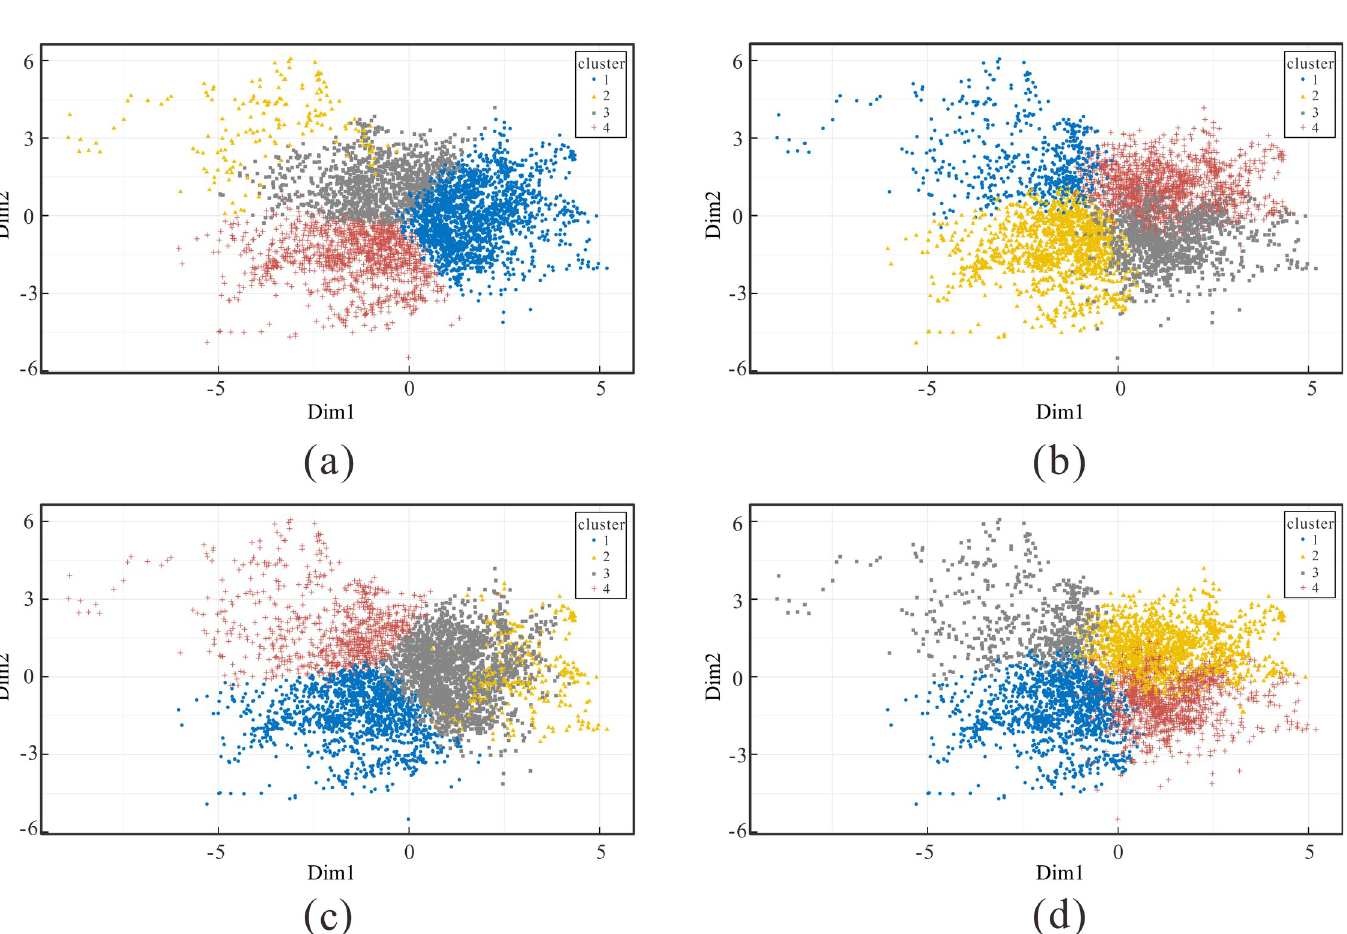
Fig 7. Comparison of the results of the improved algorithm and k-means algorithm: (a) improved algorithm; (b) k-means algorithm (first test); (c) k-means algorithm (second test); (d) k-means algorithm (third test).